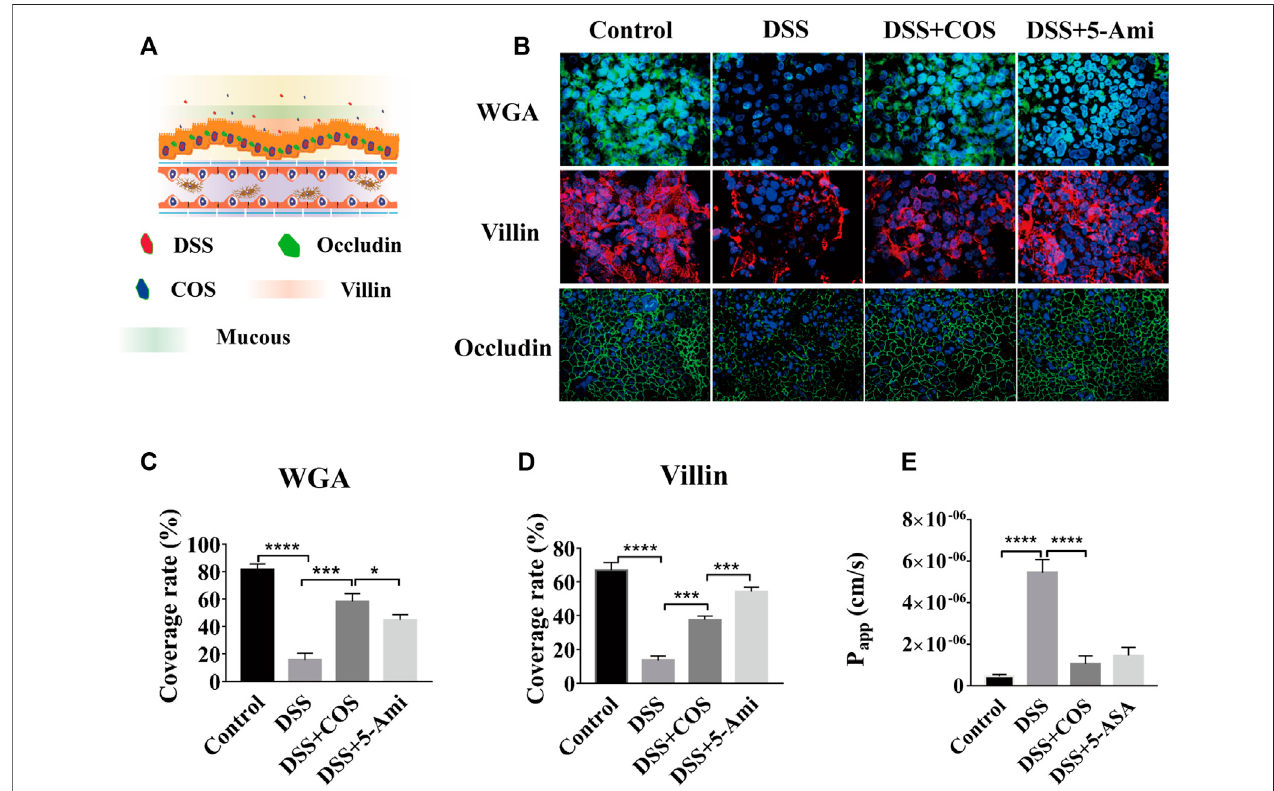
FIGURE 2 | Effects of COS on injury of gut barrier induced by DSS. (A) Schematic diagram of a model of human gut injury induced by DSS. (B) Intestinal mucin staining using WGA-FITC (Green), and immuno fl uorescence staining against villin (Red) and occludin (Green) on intestinal epithelial cells (Green). (C) The coverage of mucin on IECs. (D) The coverage of villin on IECs. (E) The apparent permeability of FITC-dextran (4 kDa) across intestinal epithelium. Data were represented as mean ± SD ( n = 3); One-way ANOVA test was performed, * p < 0.05, *** p < 0.001, **** p < 0.0001.